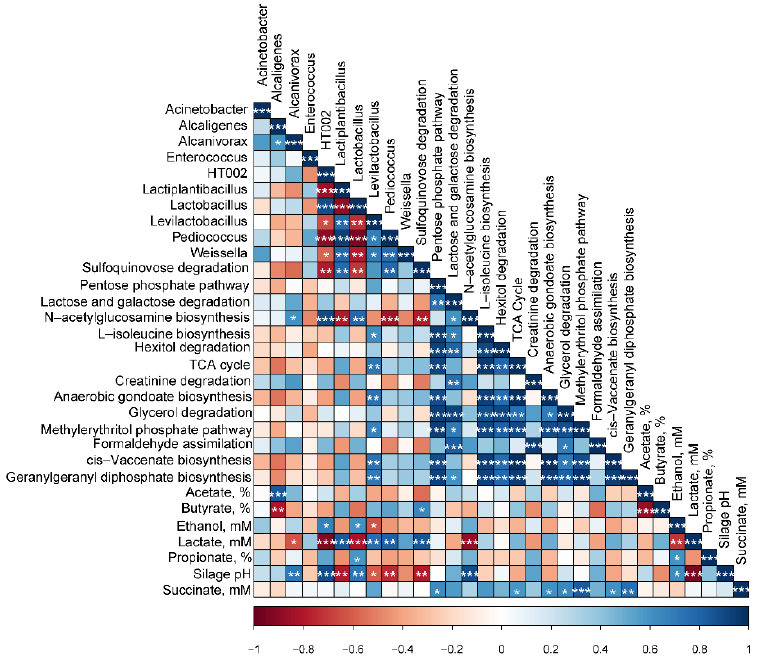
Figure 3. Correlation coefficients of bacterial communities and MetaCyc pathways identified by the linear discriminant analysis effect size (LEfSe) tool as significantly affected by vegetable mixture, correlated with common silage fermentation parameters. Positive correlations (blue) and negative correlations (red) are considered significant where * < 0.05; ** < 0.01 and *** < 0.001.